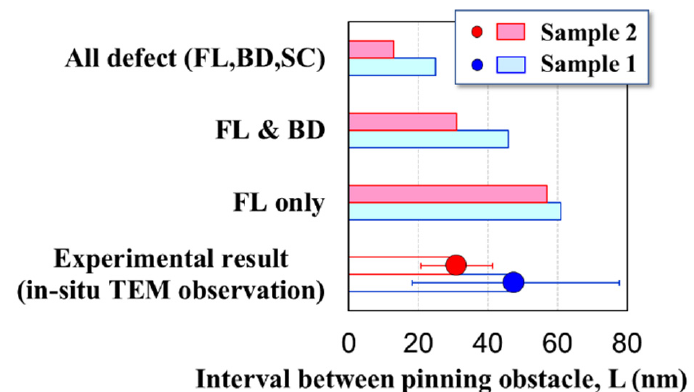
Figure 7. Obstacle intervals observed in irradiation samples 1 and 2. Obstacle type is classified into three types: all defects including FL, BD, and SC; FL and BD; and FL only. Experimental data of jump distance from in-situ TEM observation were shown as deep blue and deep red for samples 1 and 2, respectively.